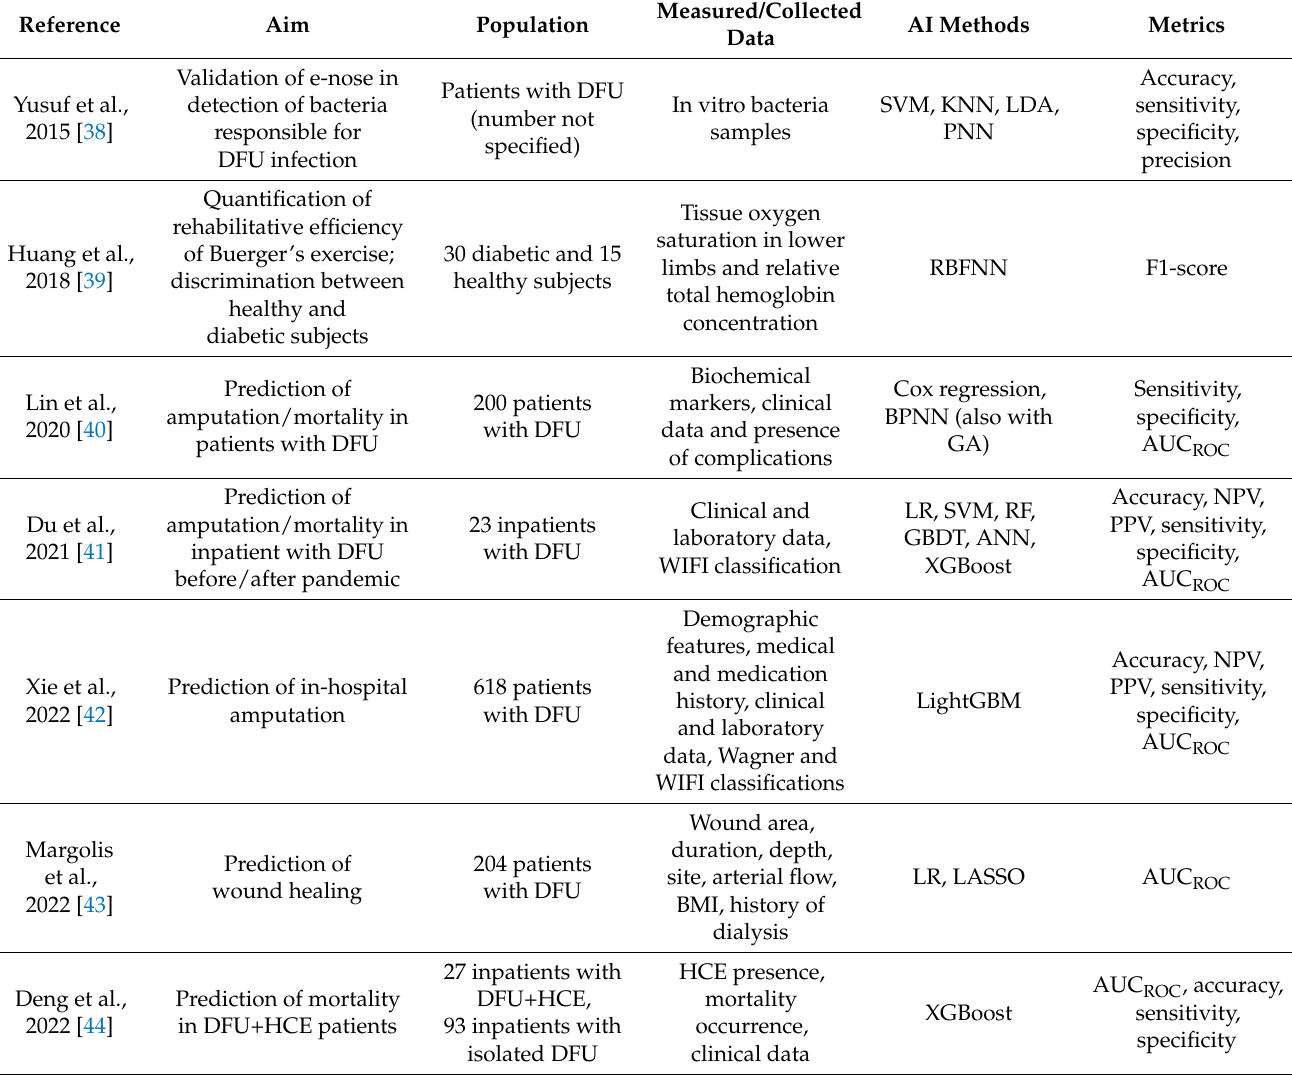
Table 3. Summary information related to the studies about overt diabetic foot ulcers—studies based on socioeconomic and sociodemographic data, and on different measured clinical data, but without imaging. The list of abbreviations is reported in the Abbreviations